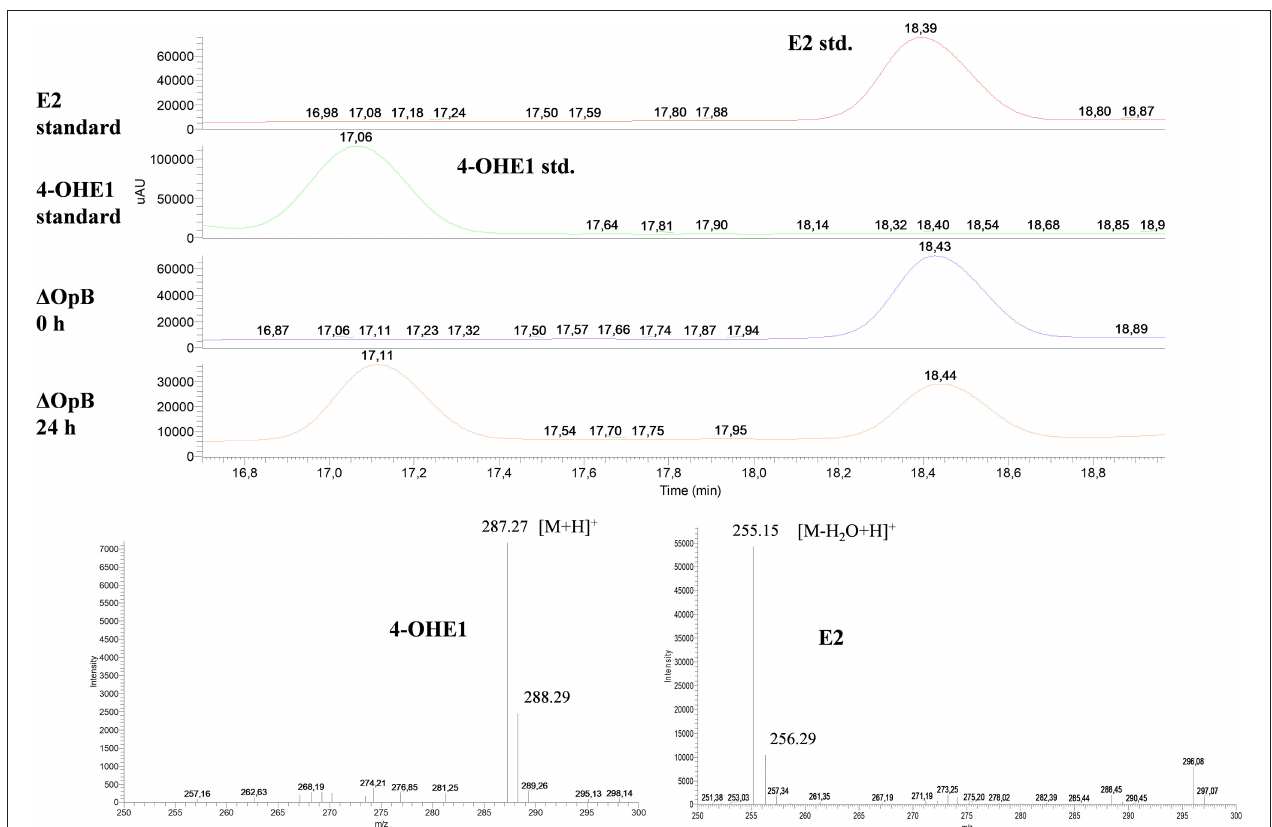
FIGURE 4 | HPLC-MS analysis of the organic phase extracted from cultures of N. tardaugens 1 OpB growing on NB rich medium supplemented with 2mM E2. DAD ( diode array detector ) chromatograms at 50–600nm of the E2 and 4-OHE1 standards and 1 OpB samples at 0 and 24h and mass spectra of the peaks detected in 1 OpB at